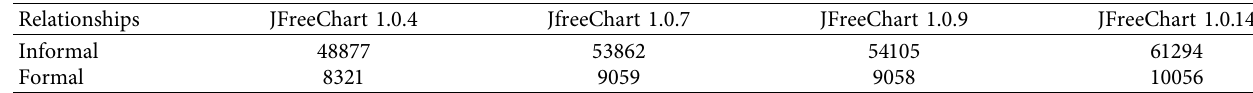
Table 11: Formal and informal relationships in JFreeChart.